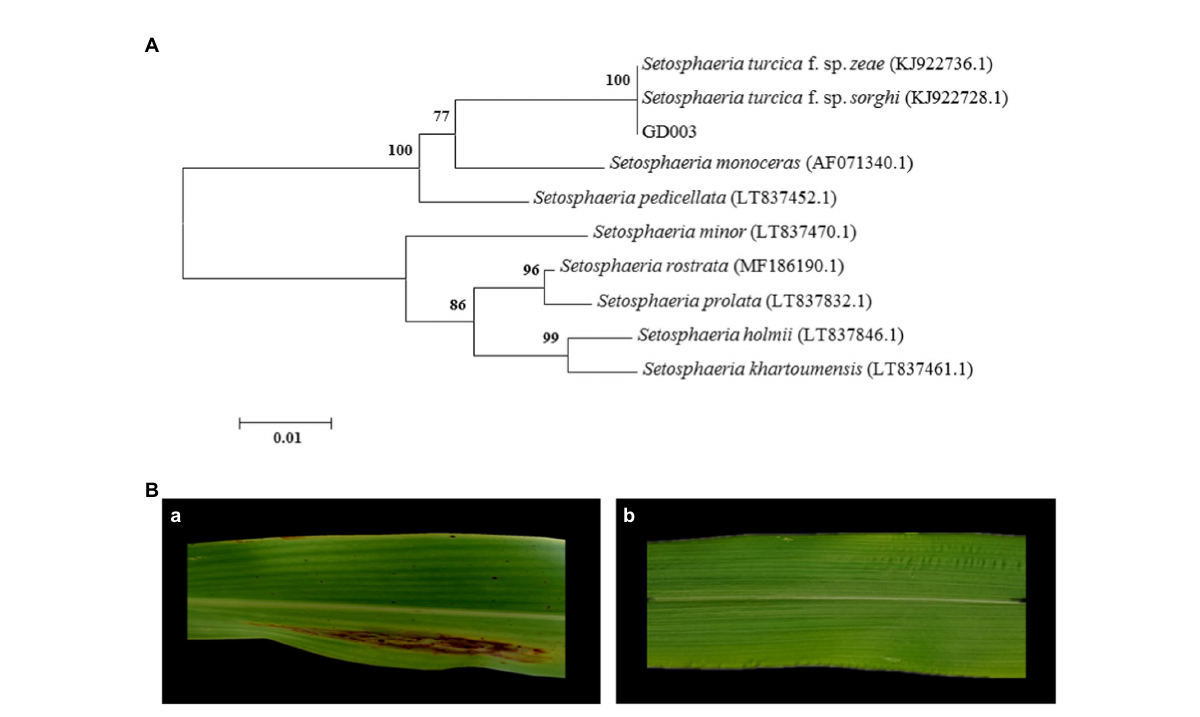
FIGURE 1 Identification of GD003 based on ITS sequences and pathogenicity. (A) Phylogenetic analysis of ITS sequences of GD003. The numbers in parentheses indicate the accession numbers of ITS sequences of the species in GenBank. (B) Pathogenicity of GD003 strain on sorghum and corn. (a) Typical lesions of GD003 on sorghum. (b) No visible reaction of GD003 on